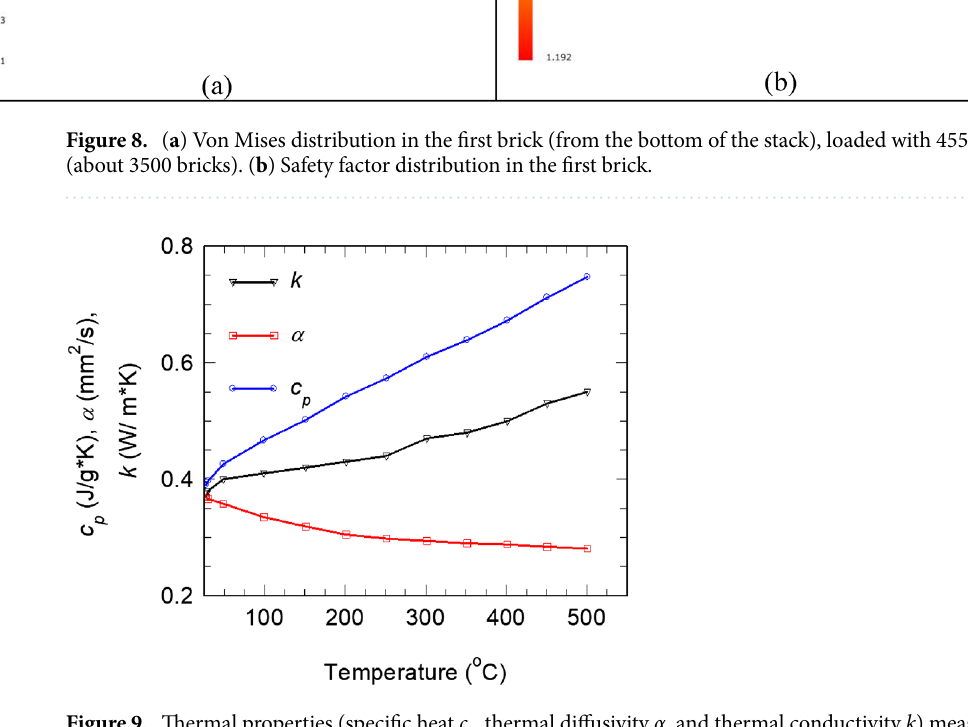
Figure 9. Thermal properties (specific heat c p , thermal diffusivity α , and thermal conductivity k ) measured in air up to 500 °C on a sample cut from the burnt brick (B) from